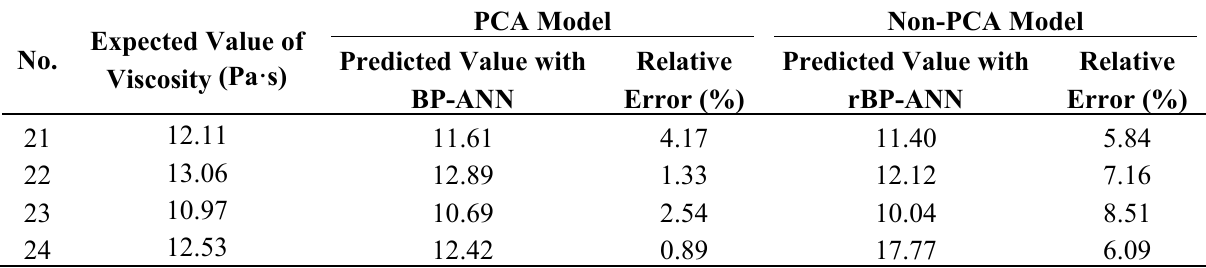
Table 12. Comparisons of predicted viscosity between the PCA model and the non-PCA model.